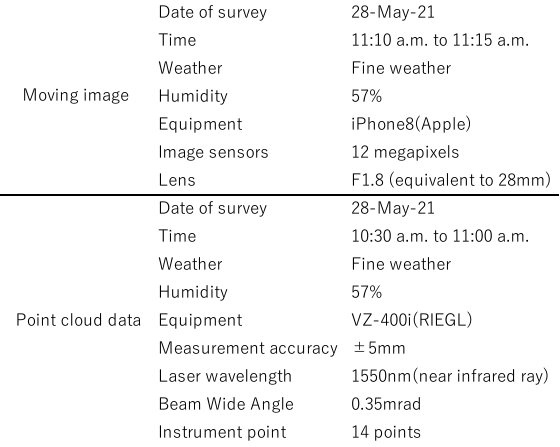
Table 1 . Summary of investigation into acquired data.